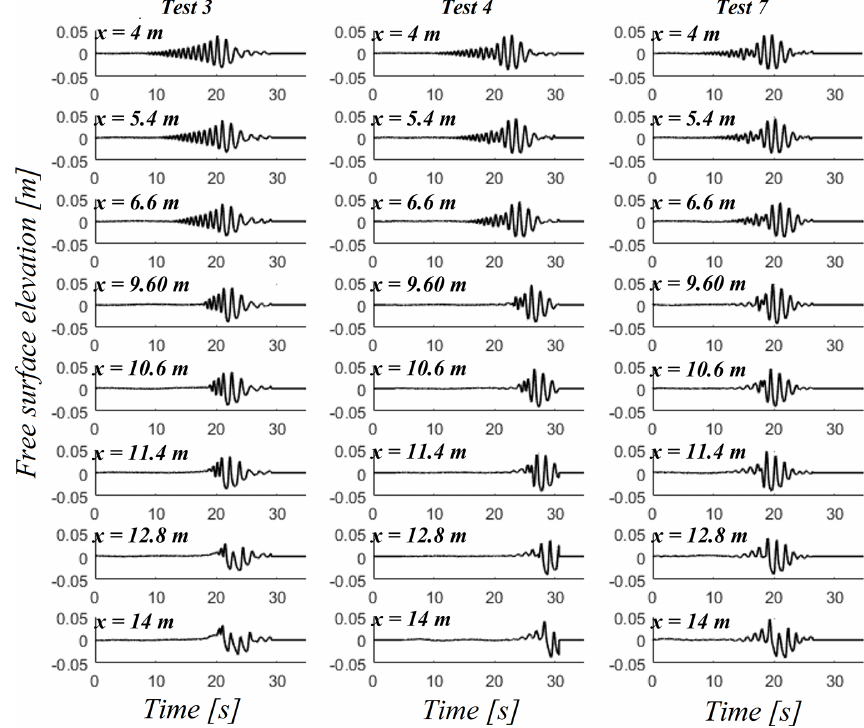
Figure 3. Three sets of time series of Pierson–Moskowitz (Test 3), JONSWAP ( γ = 3 . 3) (Test 4) and JONSWAP ( γ = 7) (Test 7) wave